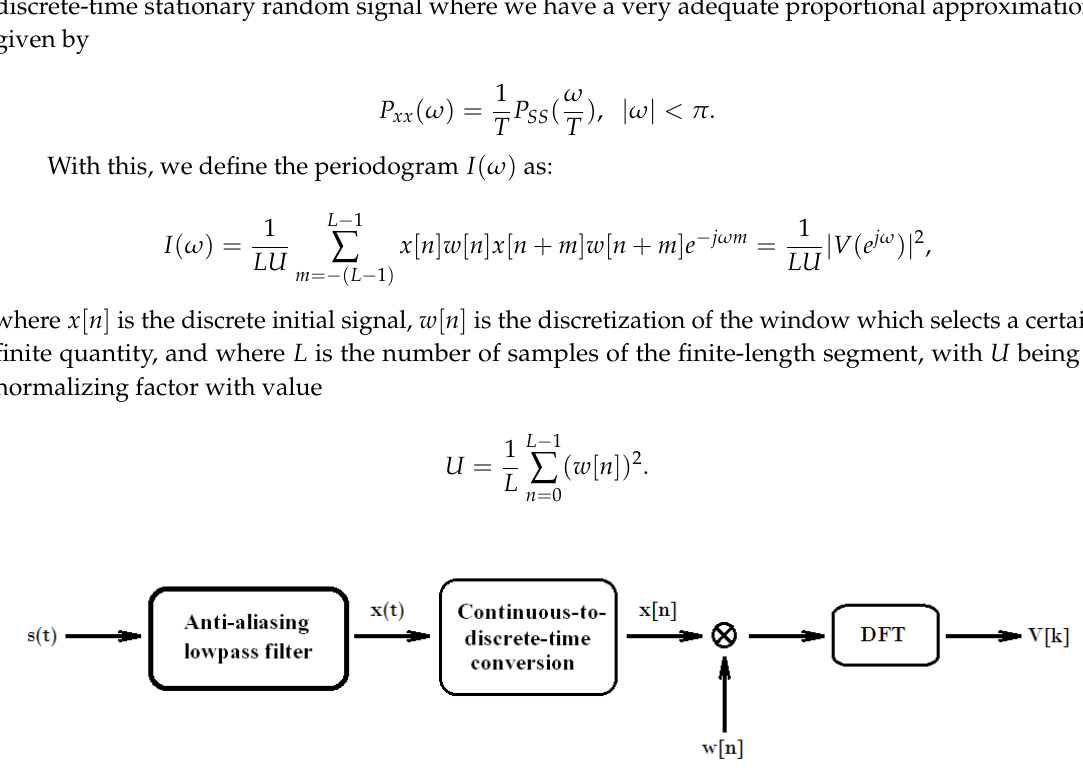
Figure 2. Scheme of steps for processing a signal from its original form to its value discretized by the discrete Fourier transform (DFT).